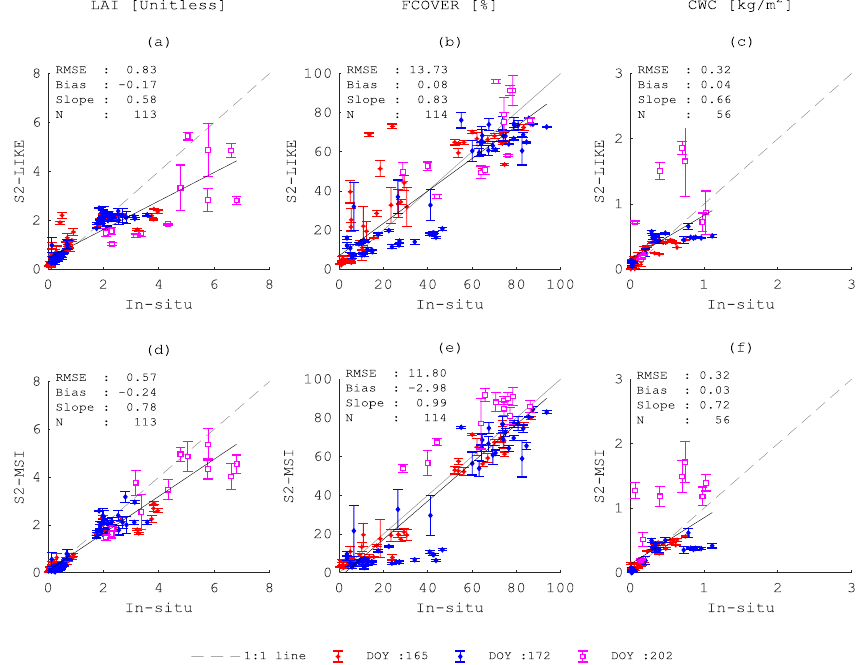
Figure 7. Vegetation biophysical variables derived using SL2P from S2-LIKE ( top ) and S2-MSI ( bottom ) images compared to in situ data.